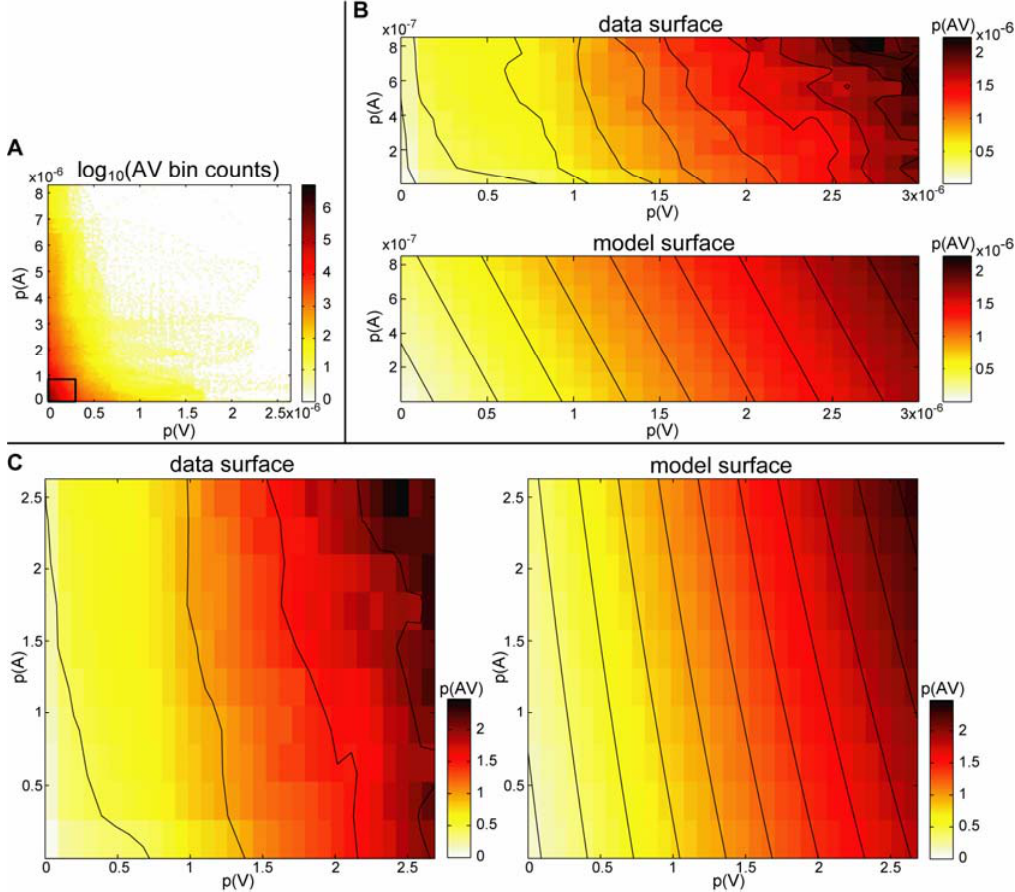
Figure 9. Interaction plots. A: The size of the complete data set is shown. Visual saliency is plotted on the x-axis and auditory on the y-axis. The number of measured AV data points falling within each bin of this space is indicated by the colour of that bin (log scale). Higher saliency areas of the space are more sparsely populated, and the data range chosen for further analysis is outlined in black. B: The resulting interaction plot for the chosen subset of data (corresponding to around 90% of total available data) is shown with iso-contours in the upper figure, with the expected value of multimodal saliency of each bin shown in colour. The shape of this surface describes the type of interaction process involved. Below is the model constructed from a linear combination of unimodal saliencies, weighted according to the coefficients calculated from (2). C: The data-driven interaction plot is shown again on the left, this time with unimodal and multimodal saliencies normalised by their geometric mean. On the right, the model resulting from the coefficients calculated from (3) is